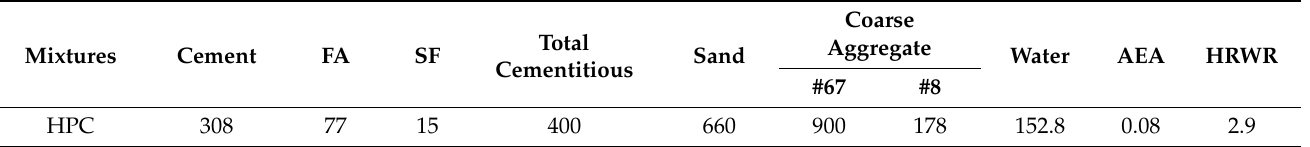
Table 2. Proportioning of the HPC nonfibrous mixture (unit: kg/m 3 ).